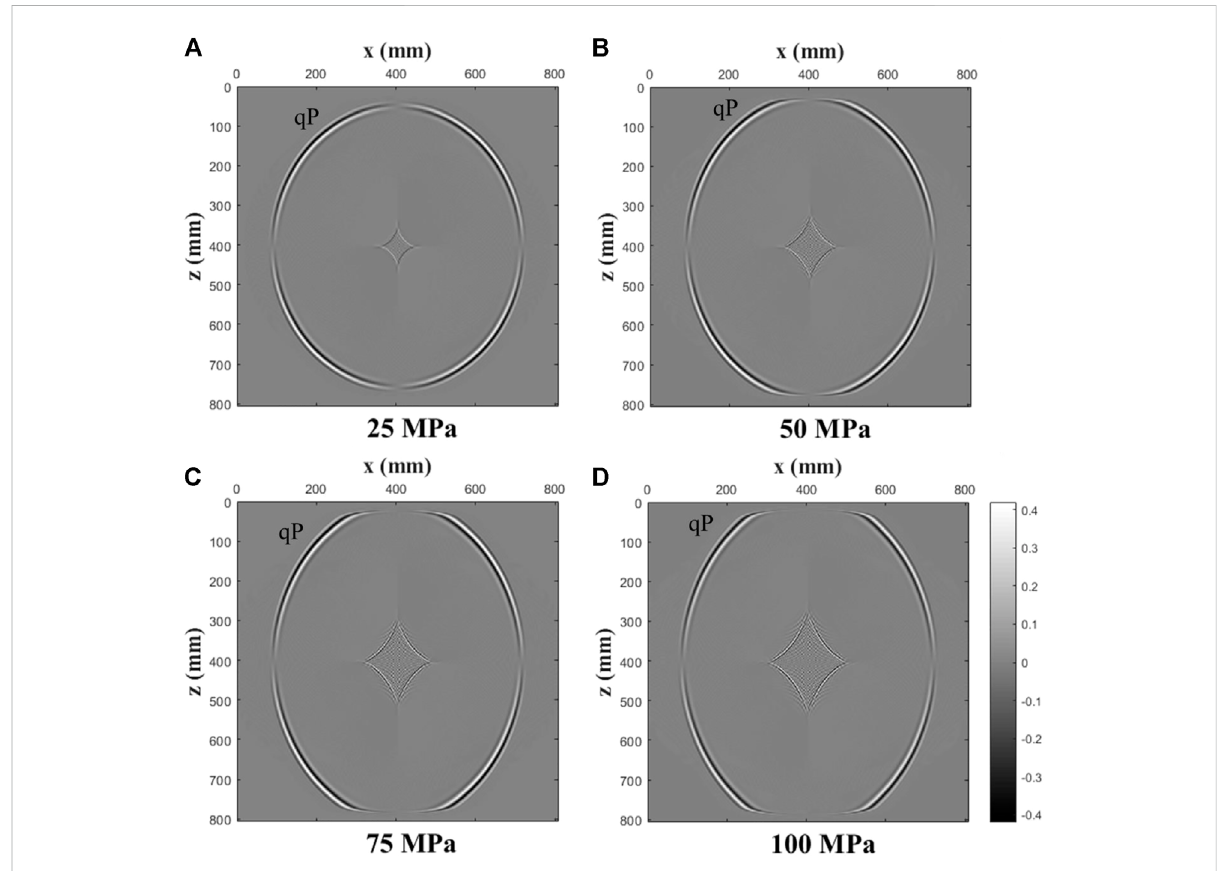
FIGURE 12 Decoupled P-wave fi eld snapshots of the x-component of the particle velocity at t = 0.1 ms for various pure shear stresses ( (A) : 25 MPa; (B) : 50 MPa; (C) : 75 MPa; (D) : 100